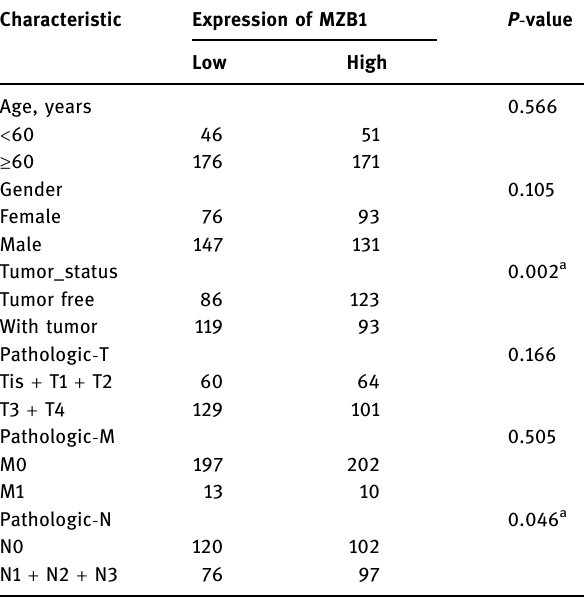
Table 3: Clinicopathological parameters of patients with cutaneous melanoma with regard to the expression of MZB1